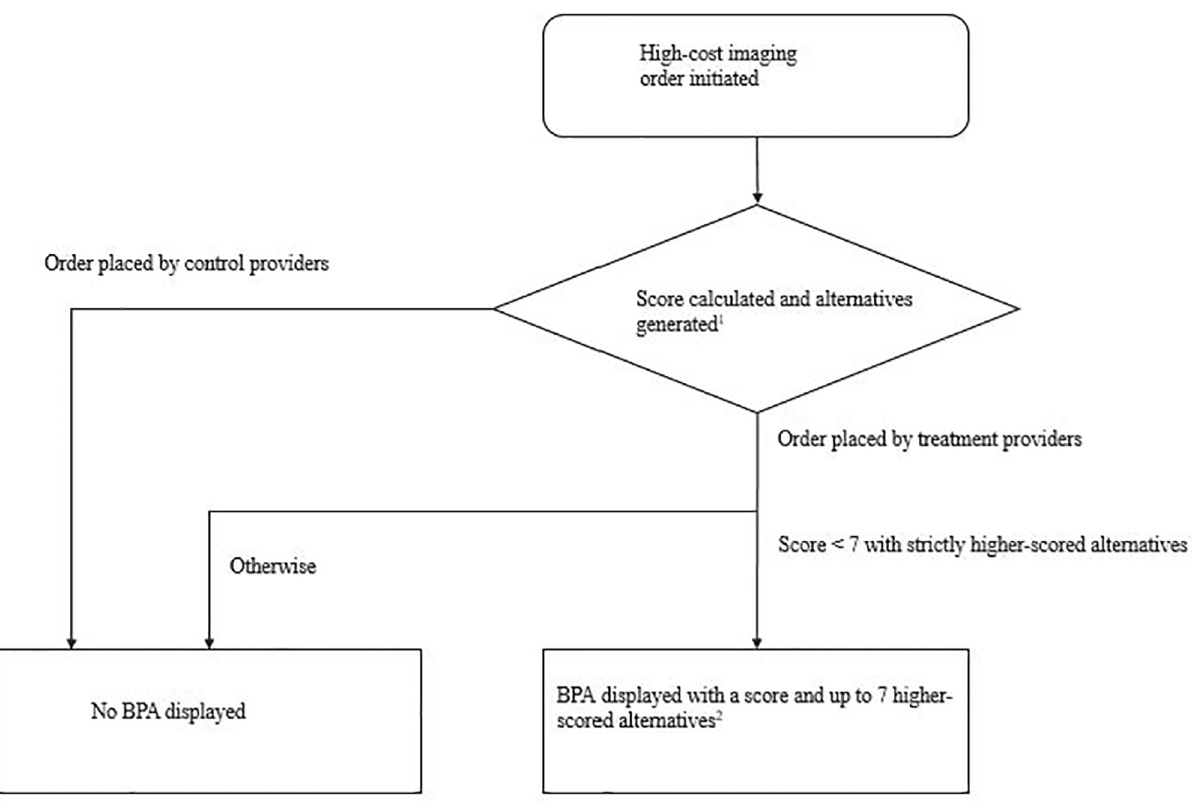
Fig 2. Logic for showing best practice alerts (BPAs). 1 Scores are calculated based on a structured indication for the patient’s health problem, a type of image, and patient information including patient age and sex. 2 Only alternatives with a score > 4 will be shown.